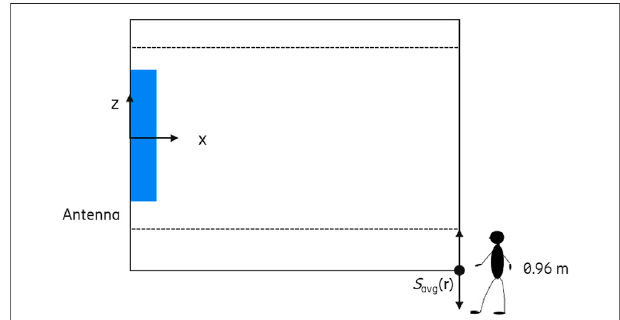
FIGURE 6 | Sketch of the compliance boundary height determined whenapplyingICNIRP2020whole-bodylimits.Theblacksolidlinerepresents the compliance boundary box derived from the S avg iso-surface. The dotted line is the resulting compliance boundary box de fi ned as the region outside which the exposure limit is not exceeded by any part of the body. Micro and macro BS operating at frequencies above 6